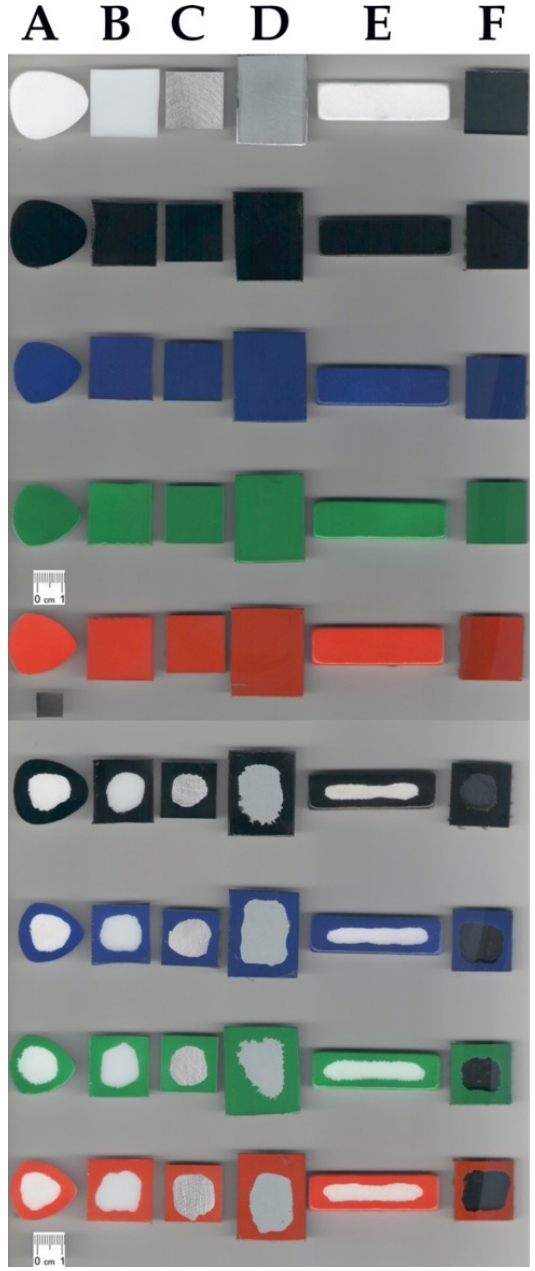
Figure 7. Complete set of samples used for the laboratory paint removal tests: ( A ) marble, ( B ) acrylic glass, ( C ) aluminum, ( D ) steel, ( E ) natural stone, ( F ) glass.